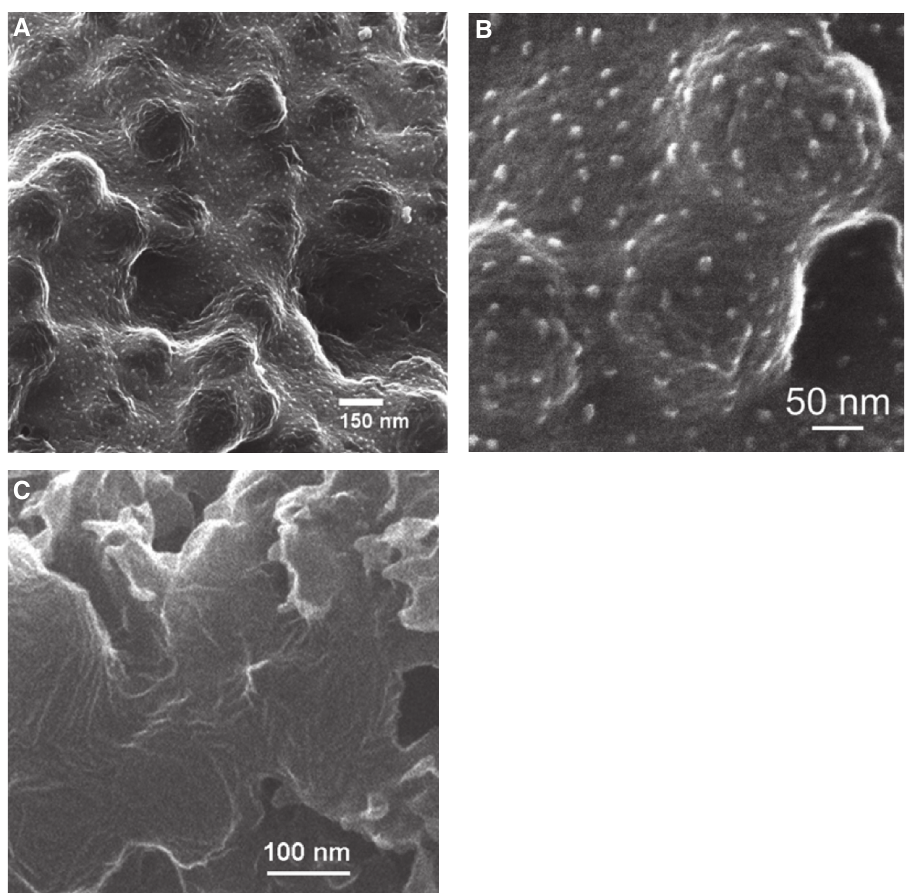
Figure 10 HIM imaging of polymer-based sensor devices; (A, B) active layer of PVDF-PANI ppb range ammonia sensor layer exposed to ammonia for a long time (phase separation and formation of dopant-ammonia salt is observed), (C) nanoporous sensor film based